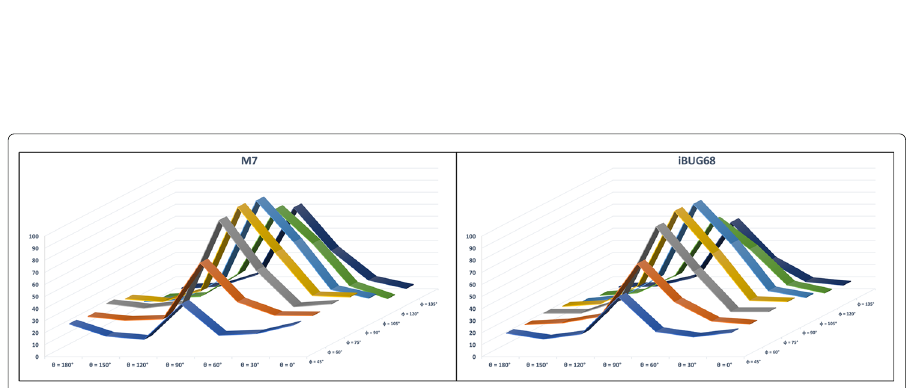
Fig. 15 PAAM: camera position varying across φ (from 45 ◦ to 135 ◦ ) and θ (from 0 ◦ to 180 ◦